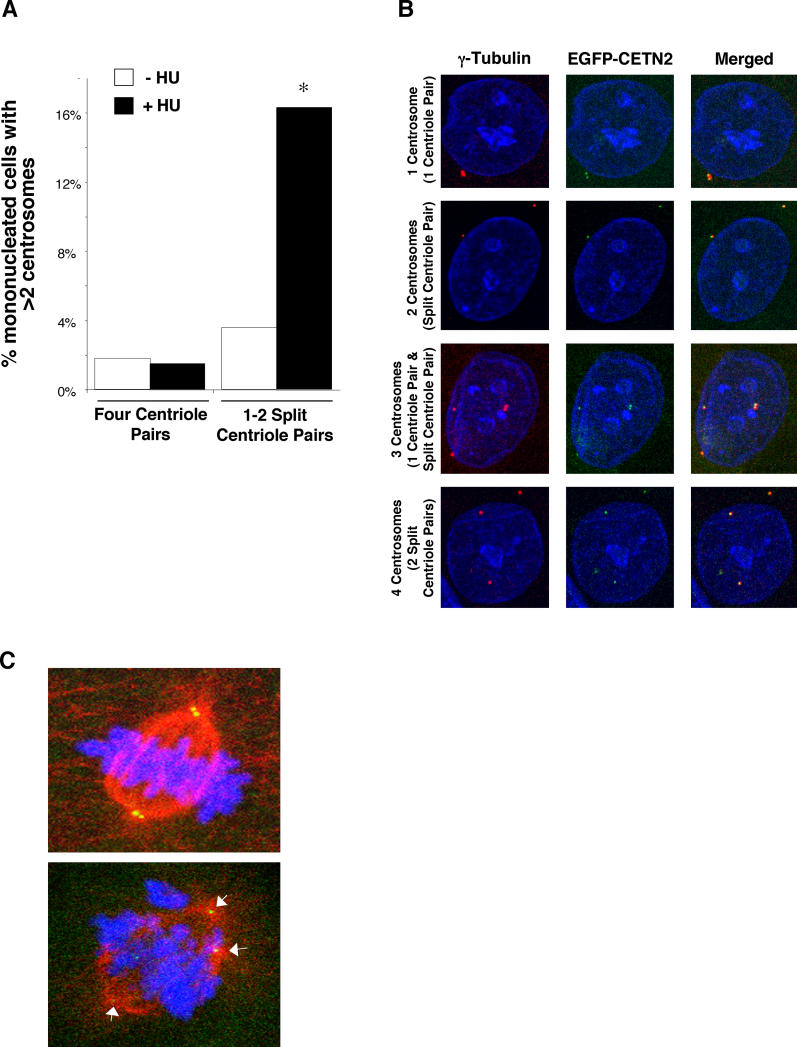
Generation of More Than Two Centrosomes in vHMECs following S Phase Arrest Is Due to Centriole Pair Splitting(A and B) Analysis of the centriole number in of the supernumerary centrosomes of early-passage vHMECs (RM15 [19 PD]) that express EGFP-CETN2 (centriole marker, green) untreated (−HU) or exposed to HU (+HU). Centrosome number was determined by immunocytochemistry with an antibody recognizing the centrosome-associated γ-tubulin protein (centrosome marker, red). Analysis included at least 100 cells (excluding binucleated cells). *Statistical significance (p < 0.005) based on comparison of −HU and +HU experiments.(B) Examples of HU-exposed vHMECs with one centrosome (containing a pair of centrioles), two centrosomes (each containing one centriole), three centrosomes (one of the centrosomes contains a pair of centrioles and two of the centrosomes have only one centriole), and four centrosomes (each containing one centriole).(C) Examples of HU-exposed and released vHMECs that express EGFP-CETN2 (green) and have been stained with a γ-tubulin antibody that recognizes microtubule spindles (red) that have two centrosomes, each containing two centriole (top), and supernumerary centrosomes, each containing one centriole (bottom). Supernumerary centrosomes with one centriole (arrowhead) can nucleate microtubules to form a multipolar spindle apparatus.